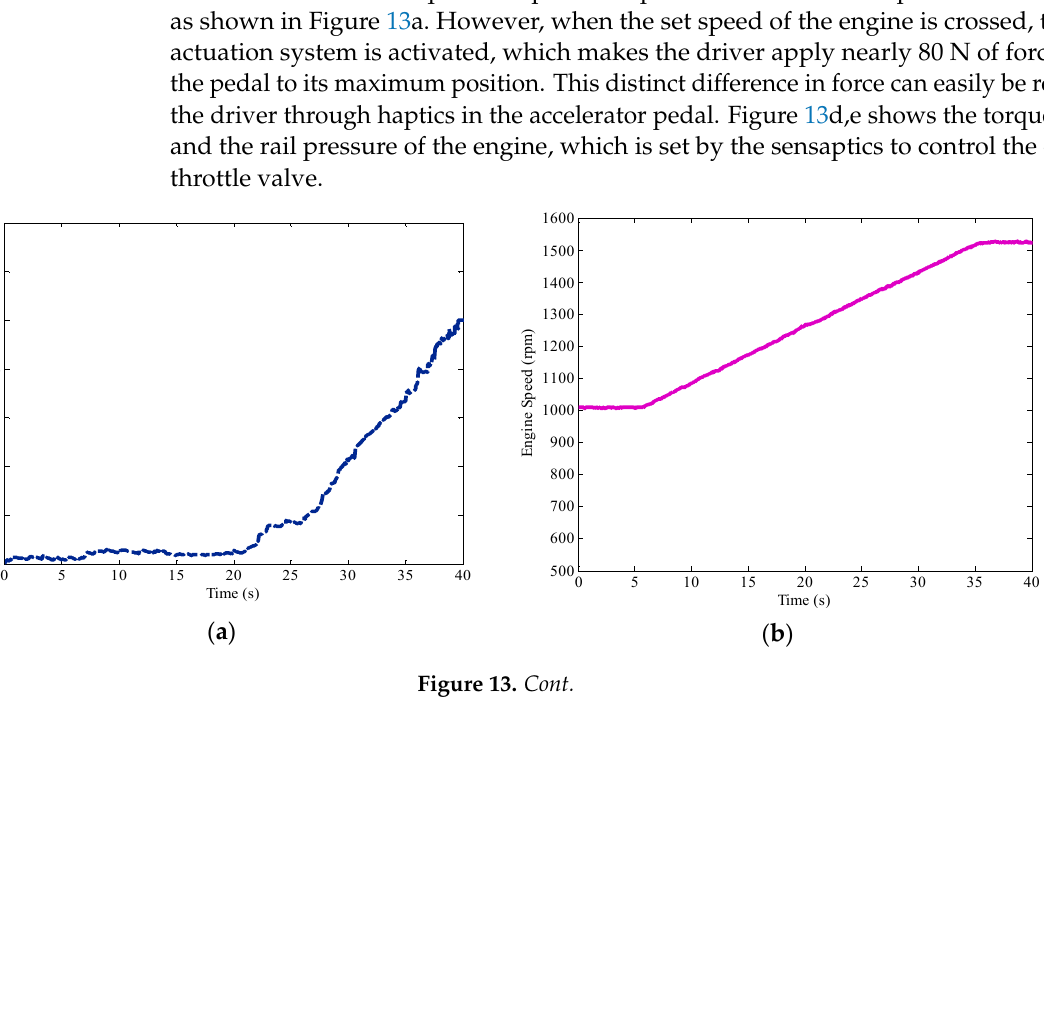
( e ) Figure 13. Test results of over speeding on common rail diesel system by the sensaptics; ( a ) sensing signal of AAP, ( b ) engine speed, ( c ) force acting on AAP, ( d ) torque demand, ( e ) rail pressure—desired and actual. 6. Conclusions A new technique is called shared sensing and actuation, wherein the SMA wires do the function of both sensing and actuation to display its bi-functionality of the element. The structure is called sensaptics, an active accelerator pedal system, based on an inte- grated sensor and actuator technique for advanced driving assistance systems using SMA for speed control and to create haptics in the accelerator pedal. The proof of concept is developed, and it is tested in the standard automobile testbed for the overspeeding and pressure regulation tests. The tests prove that the concept and the principle of operation are standard to drive a diesel engine, and AAP system design needs to be improved in